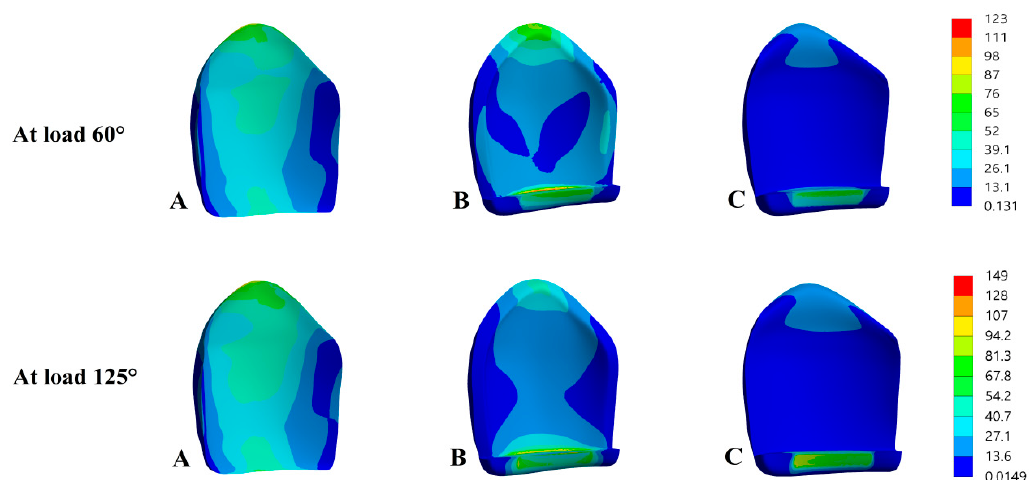
Figure 4. von Mises stress distributions (MPa) in the ceramic veneer. ( A ) Non-preparation design, ( B ) conventional preparation design, and ( C ) proposed preparation design.